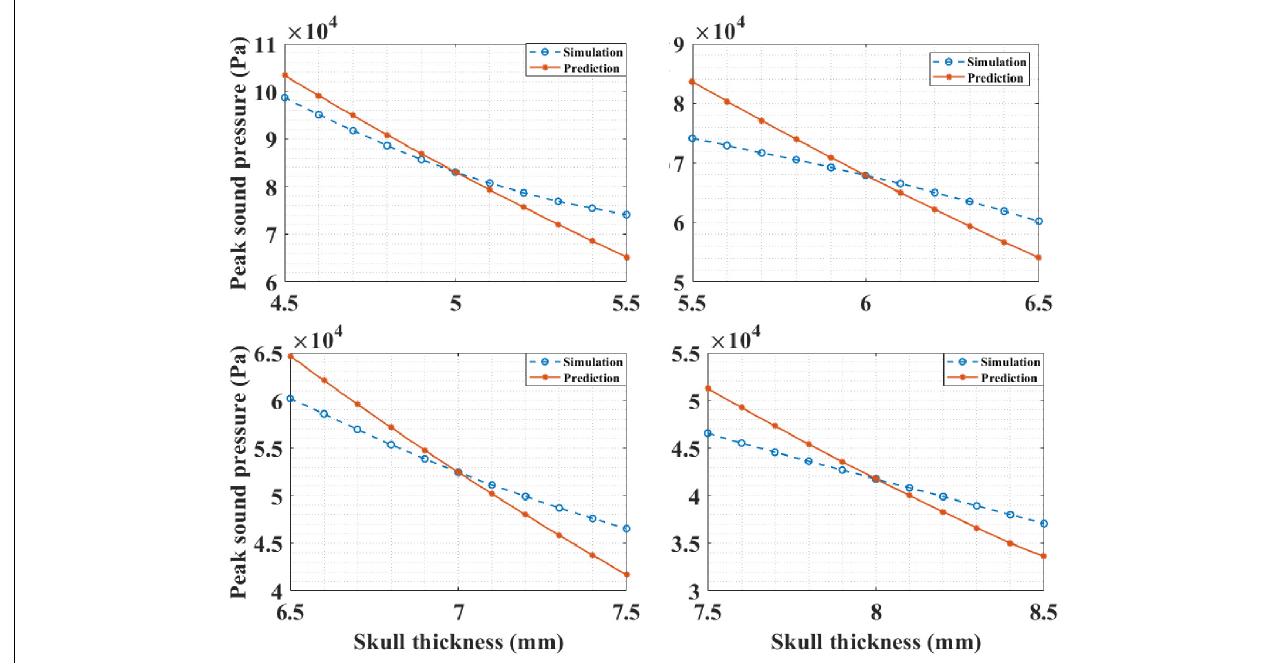
FIGURE 12 | The intracranial sound pressure results of mathematical model prediction and phantom experiment for different known skull